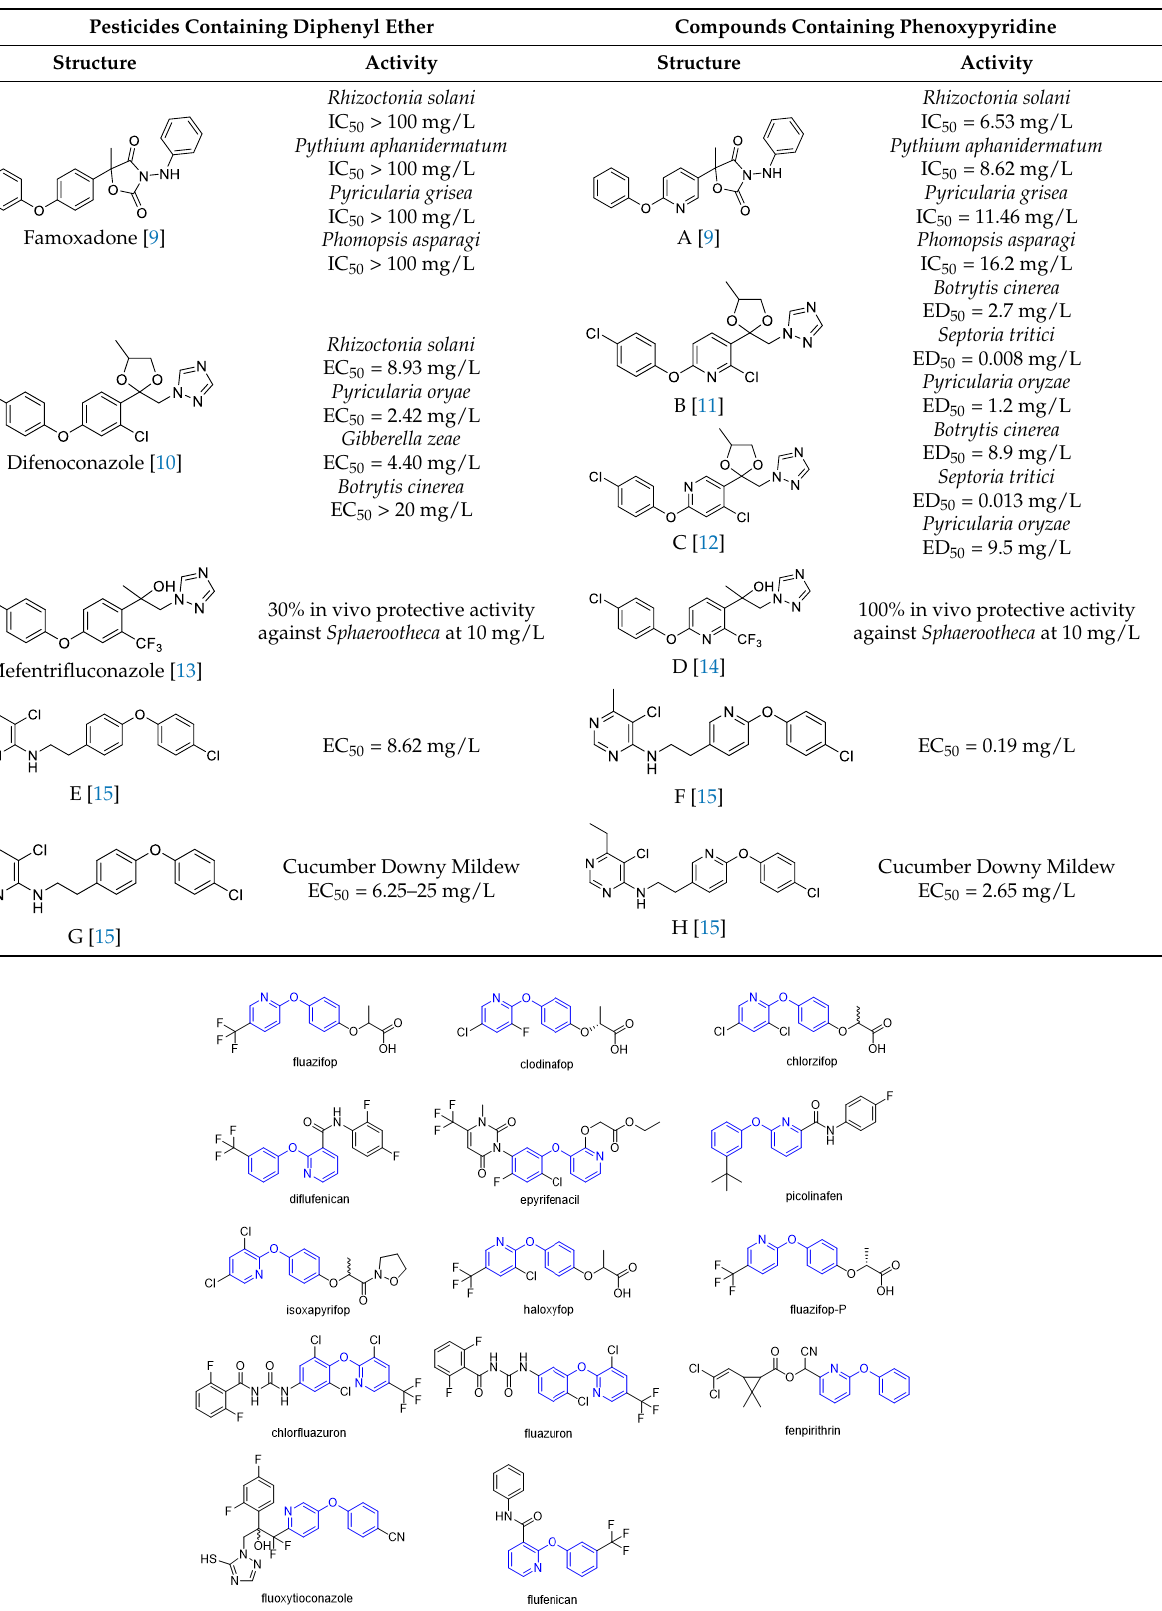
Figure 1. Selected commercial pesticides containing phenoxypyridine.